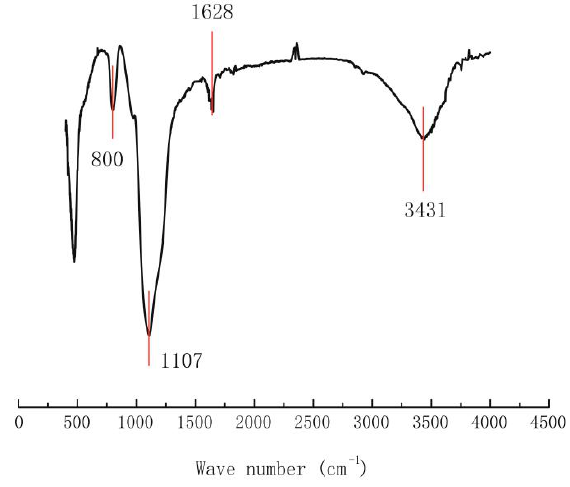
Figure 2. FTIR spectra of different silica.